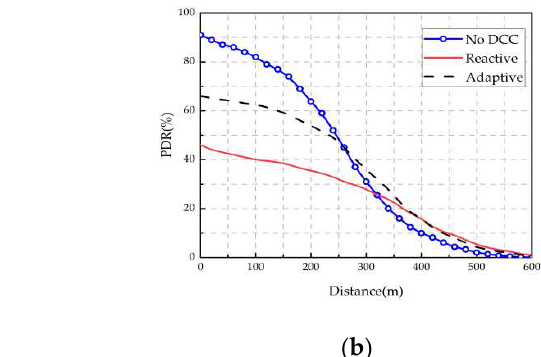
Figure 10. PDR levels for radios and applications with different DCC configurations when all packets have the same priority (DP2). Traffic density: 180 veh/km. ( a ) Radio level. ( b ) Application level.